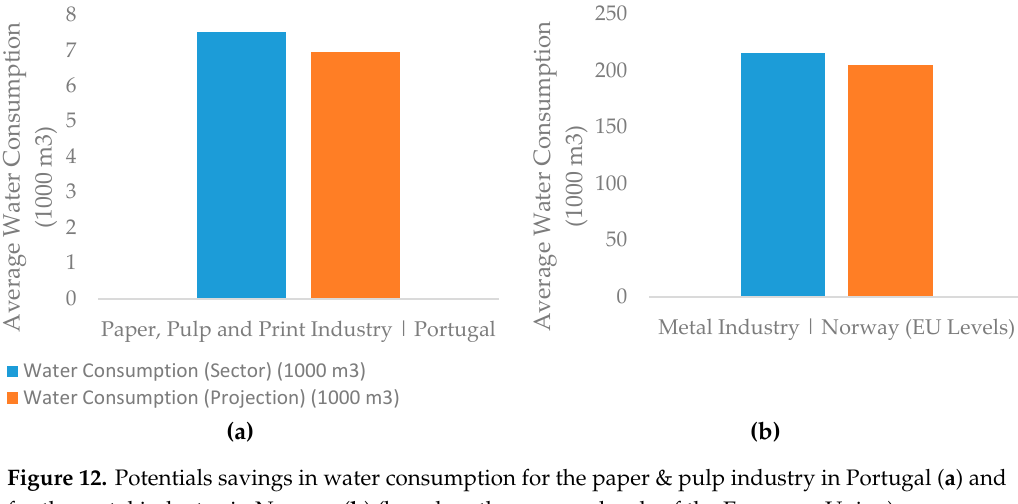
Figure 12. Potentials savings in water consumption for the paper & pulp industry in Portugal ( a ) and for the metal industry in Norway ( b ) (based on the average levels of the European Union).